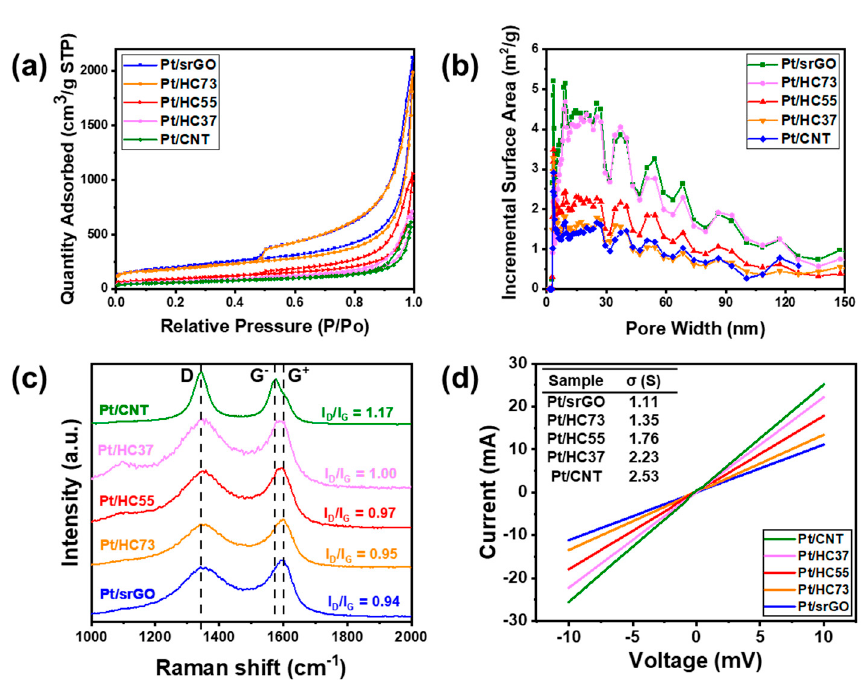
Figure 3. ( a ) BET nitrogen adsorption isotherm plot, ( b ) NL − DFT pore size distribution calculated from N 2 adsorption isotherms, ( c ) Raman spectra, and ( d ) representative IV curves of Pt/srGO, Pt/CNT, Pt/HC73, Pt/HC55 and Pt/HC37.